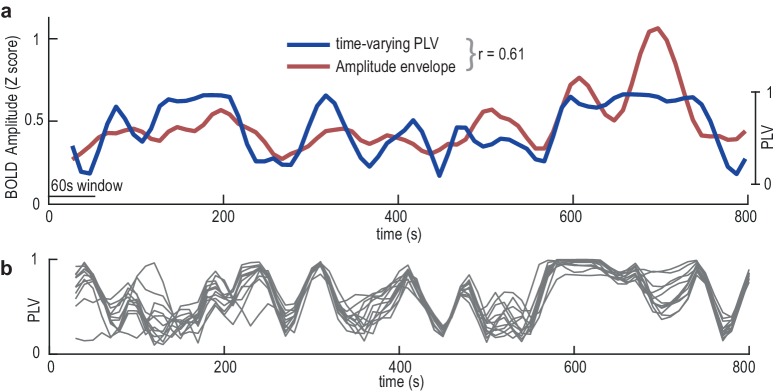
Dynamic fluctuations in EGG-BOLD coupling.(a) Data from the superior parieto-occipital sulcus in a single participant showing the correlation (r = 0.61) between the time-varying gastric-BOLD coupling (PLV, blue) and the amplitude envelope of the BOLD time series (red). (b) Time-varying PLV at each node of the gastric network in the same participant showing a strong correlation across nodes (average r across all possible node pairs 0.35).